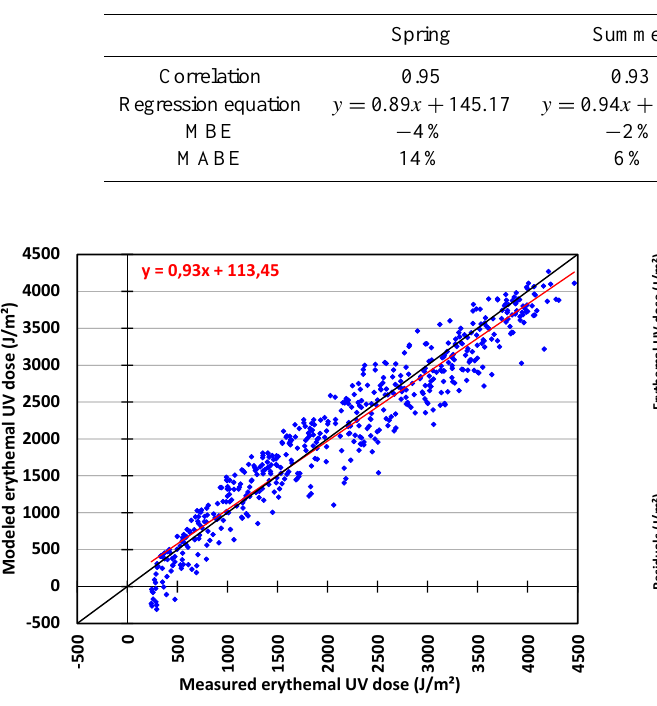
Table 9. Performance of the seasonal regression models.